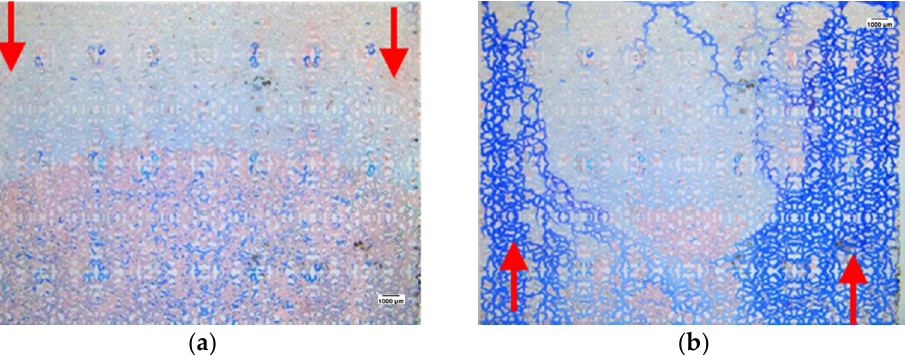
Figure 12. Injection of homogeneous model gel system and subsequent water invasion images. ( a ) The gel is injected along the simulated “horizontal wellbore”; ( b ) end of the second water flooding.